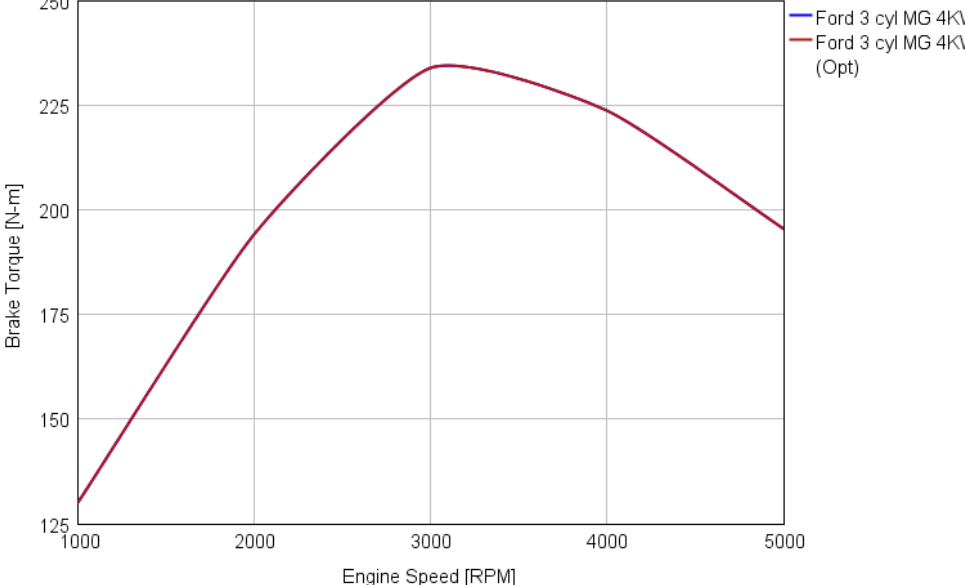
Figure 25. Brake torque of the electrically-assisted turbocharger (EAT) 4 kW model for the initial and optimized compressor.